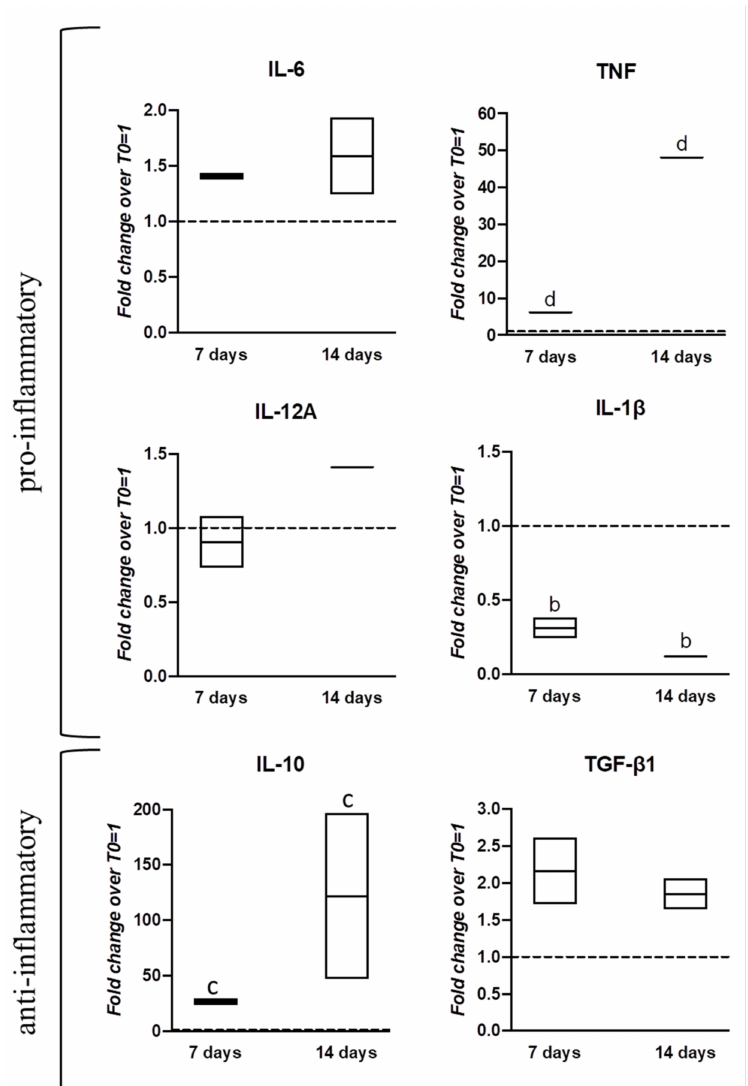
Figure 8. Gene expression profiles for cytokines by hWJ-MSCs cultured within scaffold assembled with PLGA-NCs for hGDF-5 controlled delivery. The mRNA levels of different pro-inflammatory (IL-6, TNF, IL-12A, IL-1 β ) and anti-inflammatory (IL-10, TGF- β 1) cytokines were monitored. Relative quantification of each mRNA gene expression normalized to endogenous GAPDH (internal control) was calculated using the 2 − ∆∆ Ct method and presented as fold change over hWJ-MSCs T0 = 1 (dashed line). Statistically significant differences are shown as “b” = p ≤ 0.001; “c” = p ≤ 0.005; “d” = p ≤ 0.001; compared to T0; n = 2 (biological replicates). The overexpression of pro-inflammatory factors (IL-6, TNF) was significant, together with the upregulation of anti-inflammatory ones (IL-10, TGF β